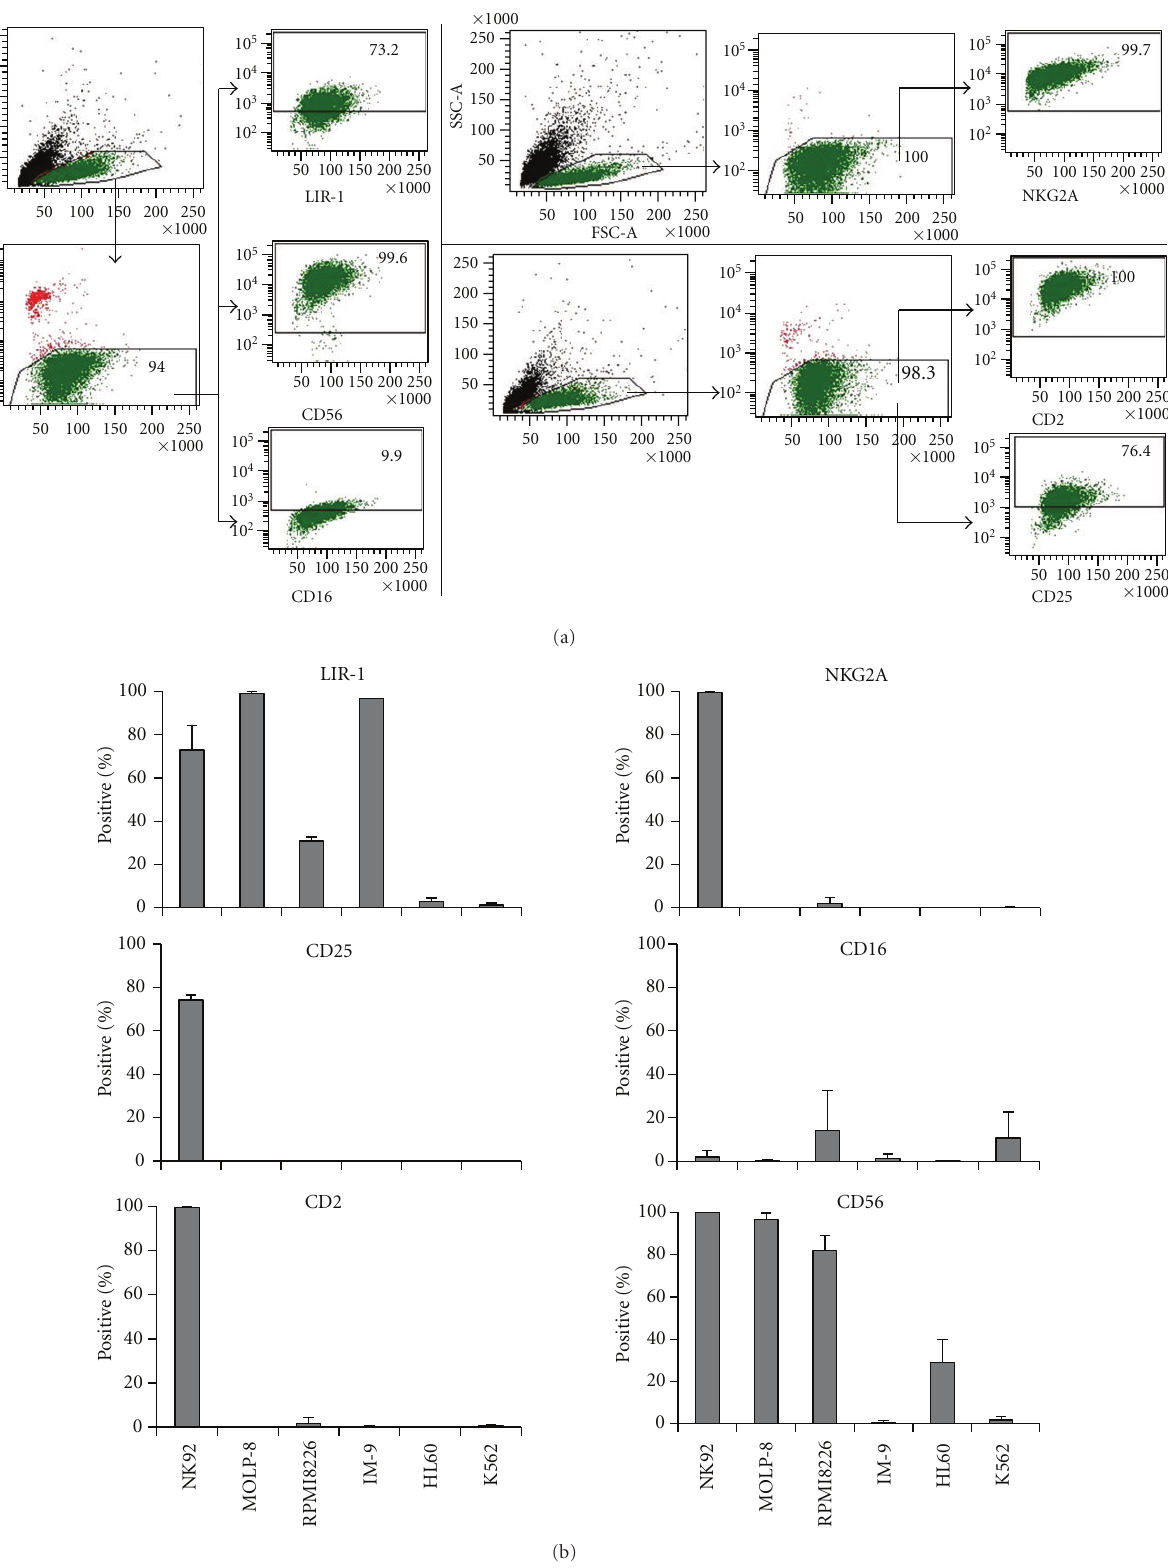
Figure 1: Expression of surface antigens. (a). Flow cytometric phenotyping of all cell lines was done with mABs against LIR-1, CD56, CD16, CNKG2A, CD2, and CD25 as shown for NK-92. (b). Surface antigen expression on NK-92 and tumor cell lines. Values given as % positive staining after subtraction of isotype